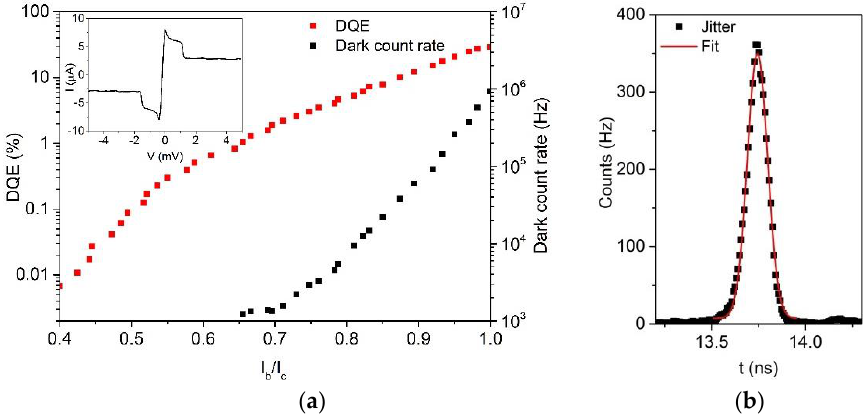
Figure 4. ( a ) Device quantum efficiency (DQE) (red) of a 20 µm-long SSPD on top of SNB under illumination at 1300 nm, and dark count rate (black) as a function of the normalized bias current. Inset: current-voltage characteristic. ( b ) Histogram of the jitter time of the detector biased 94% I c .